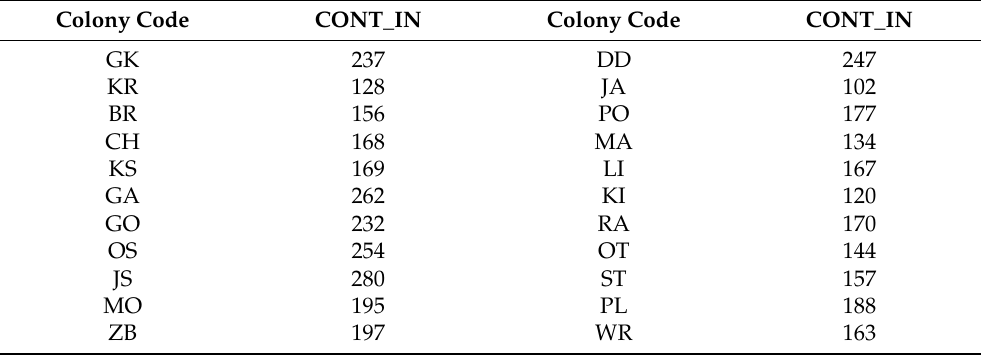
Table 2. Values of multi-contamination rank index (CONT_IN) calculated based on the measured concentrations of elements (number of eggshells available per location in brackets). Note: The lowest values indicate the highest sum of the mean concentrations of the harmful or toxic elements (Al, As, Cd, Cr, Cu, Fe, Hg, Mn, Se, Sr, V, and Zn). Colony codes—see Section